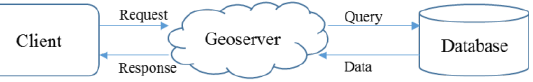
Figure 10. Python GUI for Data Aggregation